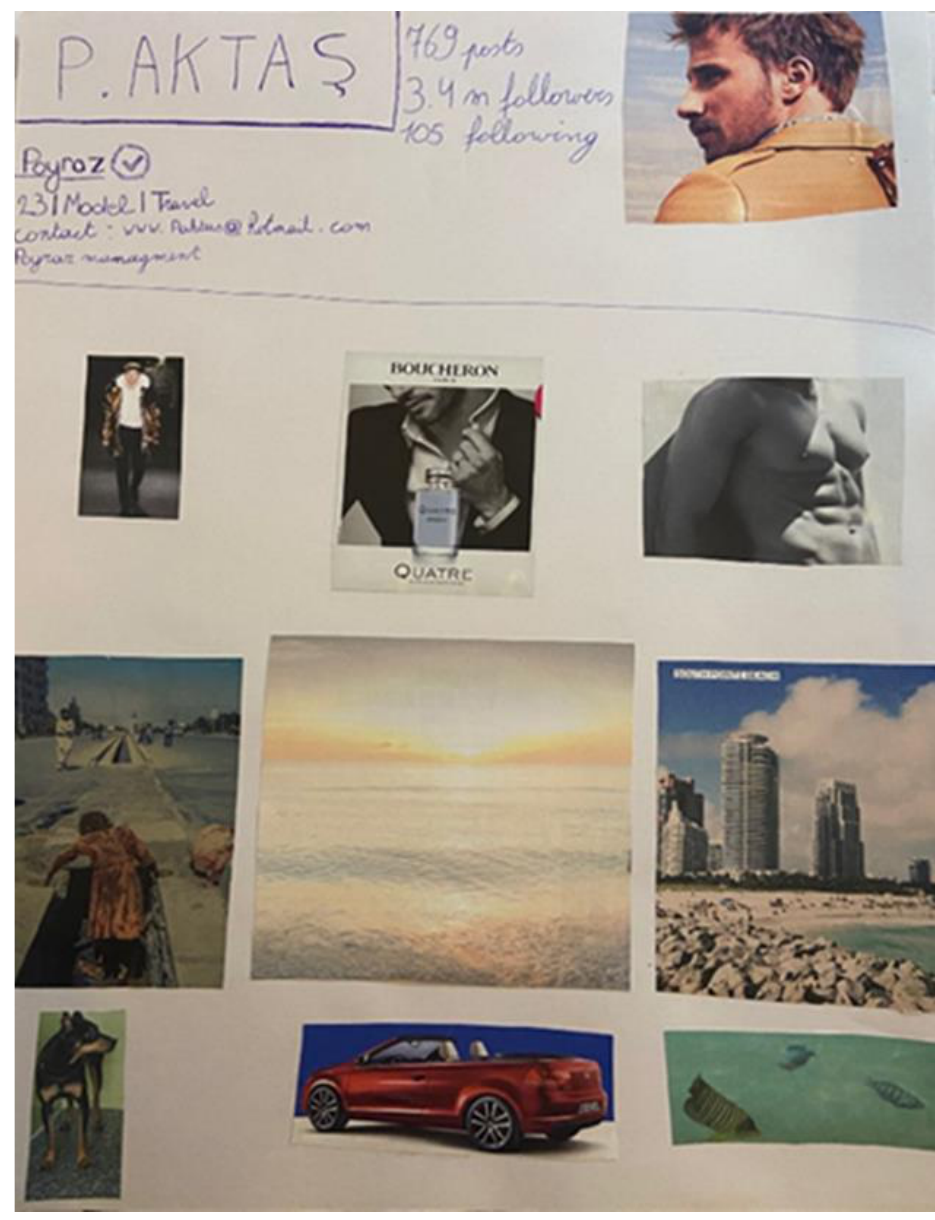
Figure 1. Poyraz Aktas - 'Ideal'